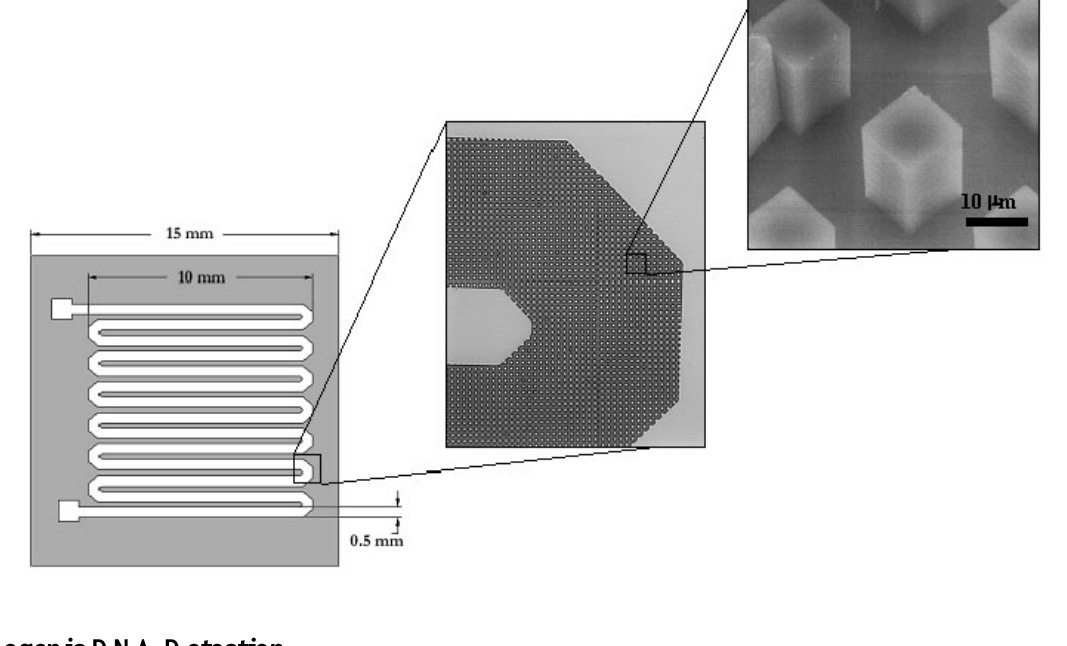
Figure 4. Schematic representation and SEM micrographs of channels containing microfabricated silica pillars used for microchip DNA purification (reprinted with permission [48], © 2003 Elsevier Science